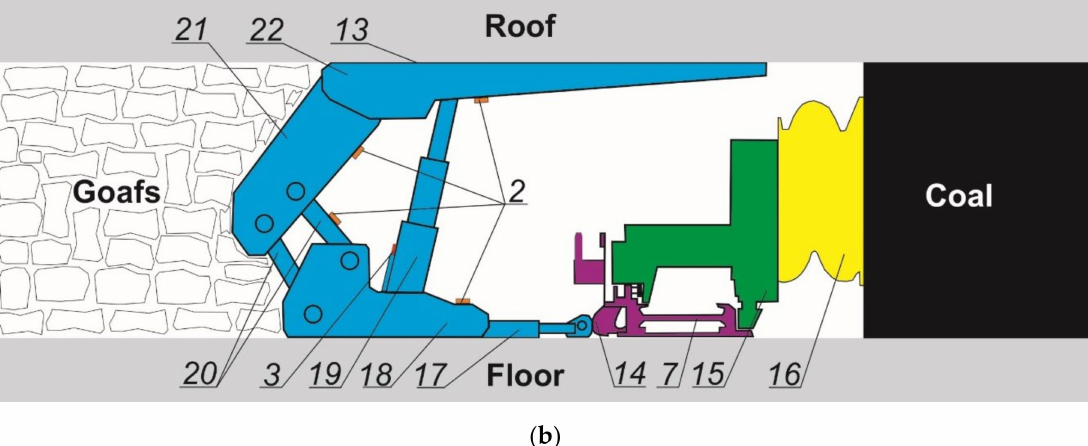
Figure 1. Arrangement of machines and equipment in a longwall complex: ( a ) cross-section of the longwall and ( b ) longitudinal section of the longwall, where 1—power supply, 2—inclinometer, 3—pressure sensor, 4—central controller, 5—controller with an executive block, 6—route sensor, 7—longwall scraper conveyor, 8—belt conveyor, 9—shearer control station with closed circuit television, Closed Circuit Television (CCTV) monitors and monitoring of operating parameters of the powered roof support, 10—scraper conveyor, 11—crusher, 12—CCTV camera, 13—powered roof support, 14—sliding system connection with a scraper conveyor, 15—shearer, 16—cutting unit, 17—sliding system, 18—floor base, 19—hydraulic leg, 20—lemniscate system, 21—shear support, and